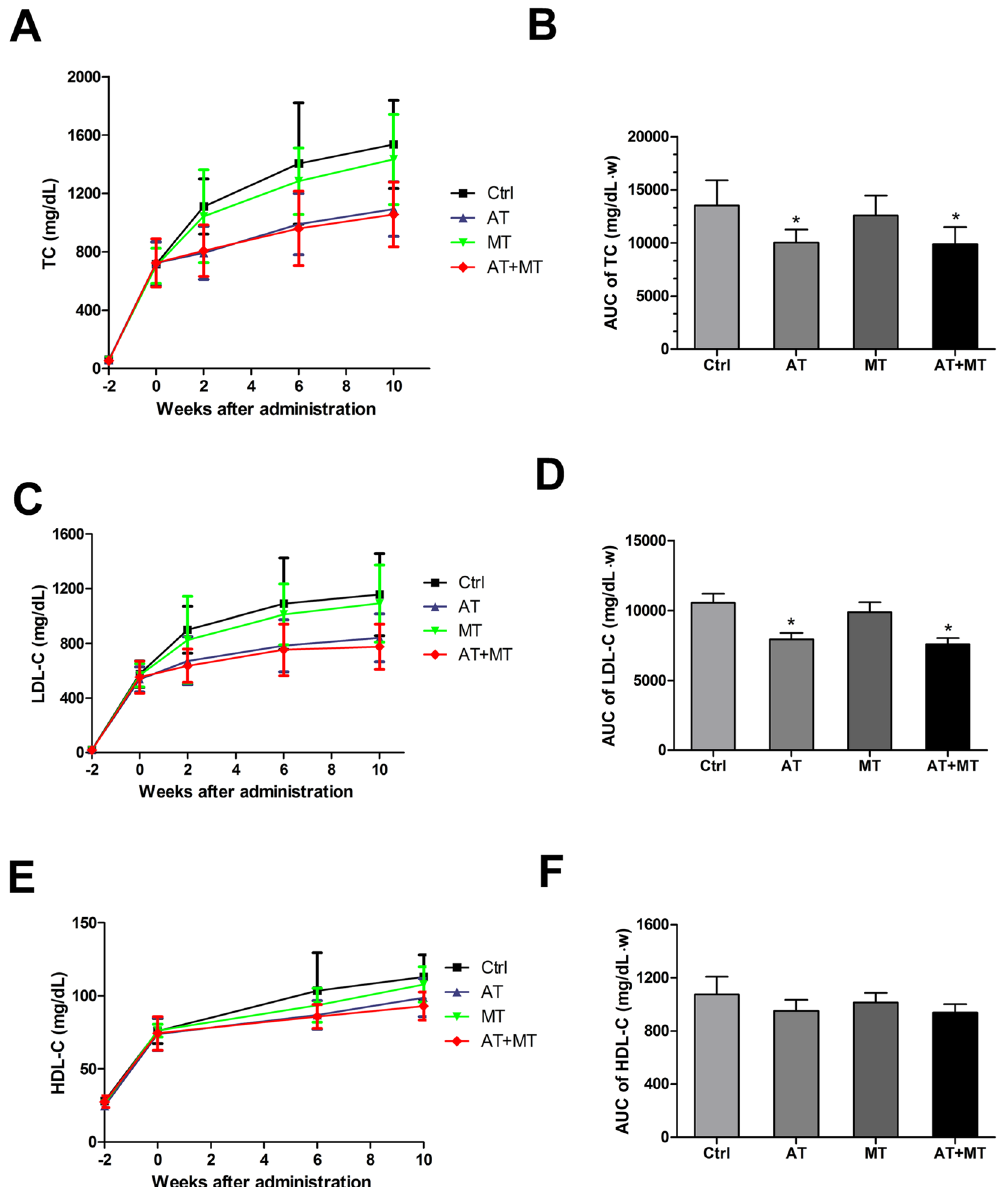
Figure 2. Metformin added to atorvastatin therapy has no additional lipid-lowering effect. At the beginning of the experiment, rabbits were fed a high-cholesterol diet. After 2 weeks, rabbits were randomly stratified into the normal sodium (Ctrl group), atorvastatin (AT group), metformin (MT group), or atorvastatin/metformin combination therapy (AT + MT group) for a period of 10 weeks. Lipid levels were measured at − 2, 0, 2, 6, 10 weeks after drug administration. Time-dependent changes and their AUC values of serum TC levels ( A , B ), LDL-C levels ( C , D ) and HDL-C levels ( E , F ) are presented. Data are mean ± SD, n = 7 for each group. * P < 0.05, compared with Ctrl group. AUC, area under the curve; HDL-C, high-density lipoprotein cholesterol; LDL-C, low-density lipoprotein cholesterol; TC, total